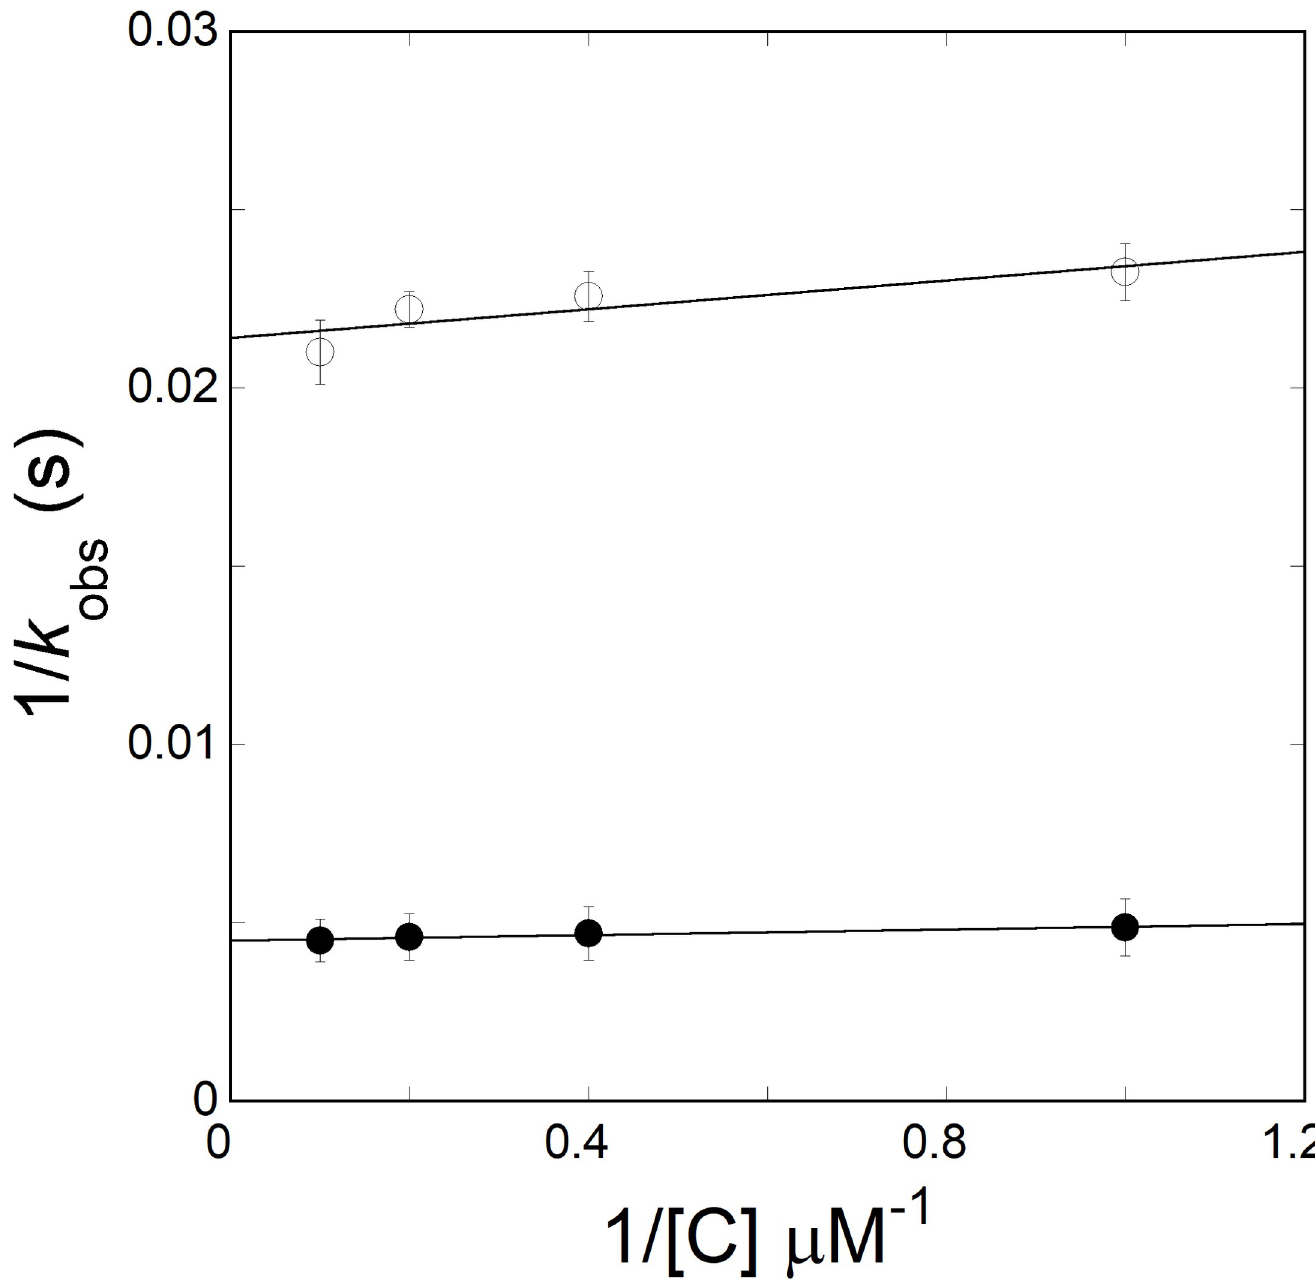
Fig 2. Dependence of k obs on VPg concentration for reactions conducted with phosphorylated and unphosphorylated eIFiso4E. The value of k 2 obtained for reaction of the mixture of 0.2 μ M of eIFiso4Ep (—•—) or eIFiso4E (—o—) with VPg (1–10 μ M) from the reciprocal of the y intercept of the plots of 1/ k obs versus 1/ [C]. k 2 was determined from a least-squares fit of the data to a linear function ( solid line ). https://doi.org/10.1371/journal.pone.0259688.g002 k obs on VPg concentration. k 2 was determined from the intercepts of 1/[C] versus 1/ k obs , to be 56.1 ± 3.7 s -1 and 227 ± 14.0 s -1 , respectively, for eIFiso4E � VPg and eIFiso4Ep � VPg complexes. Temperature-dependent observed rate constant ( k ) was calculated from the data sets col- obs lected at each temperature for the binding of eIFiso4E and eIFiso4Ep with VPg. The k values obs for the eIFiso4Ep � VPg and eIFiso4E � VPg complexes increased with an increase in temperature